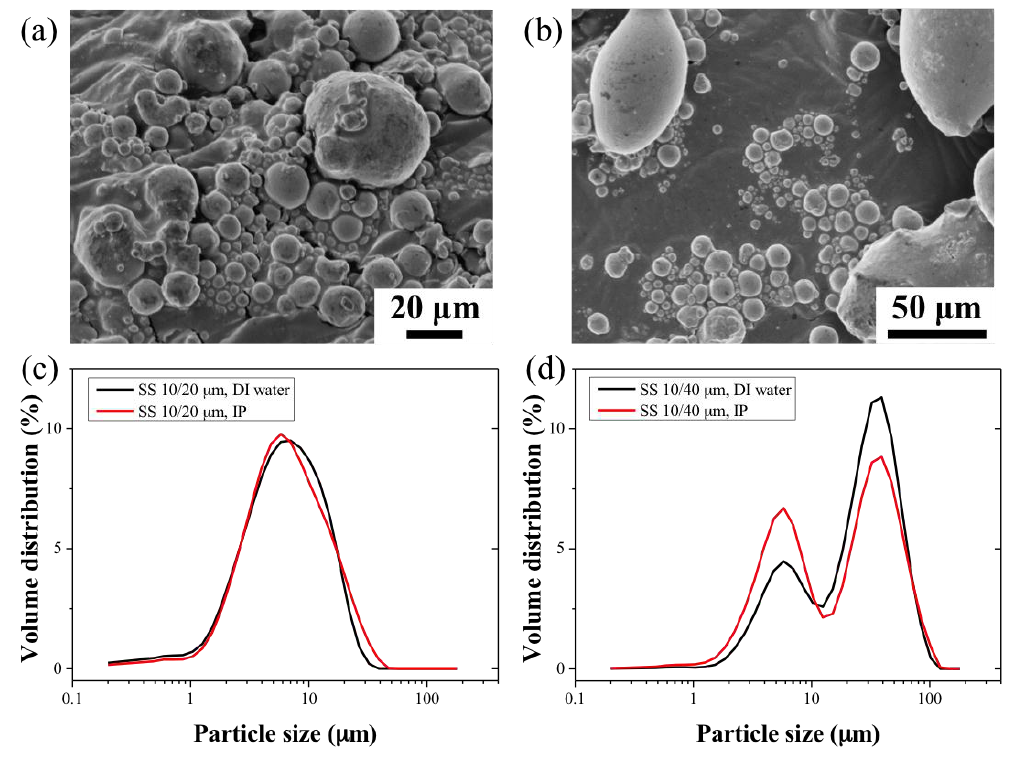
Figure 2. SEM images of ( a ): the 10/20 μm SS powder blend and ( b ): the 10/44 μm SS powder blend. ( c , d ) are the respective size measurements of the powder blends in DI water and isopropanol (IP).